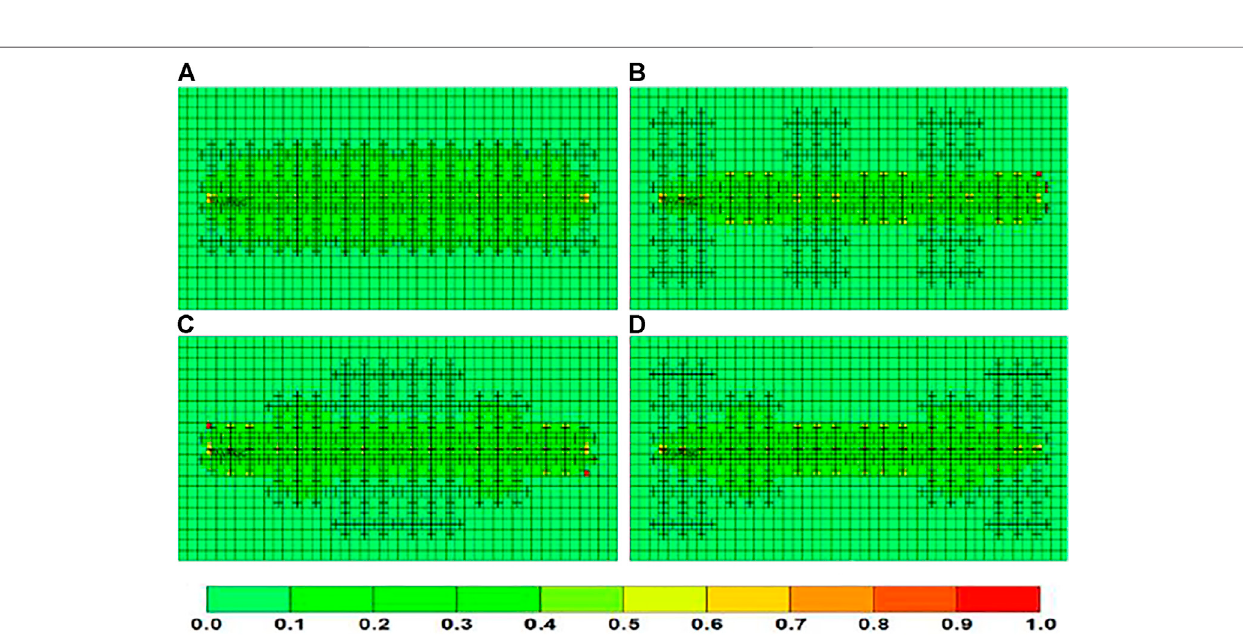
Frontiers in Earth Science |